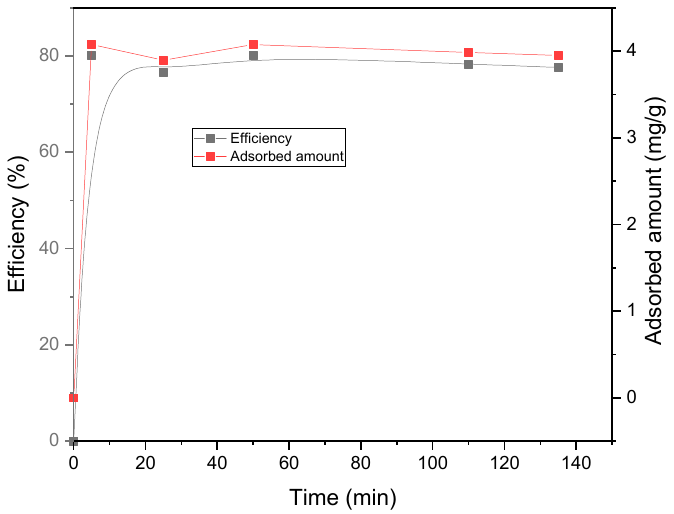
Figure 12. Trend of BR dye adsorption onto Figure 12. T r end of BR dye adsorption onto ALP.